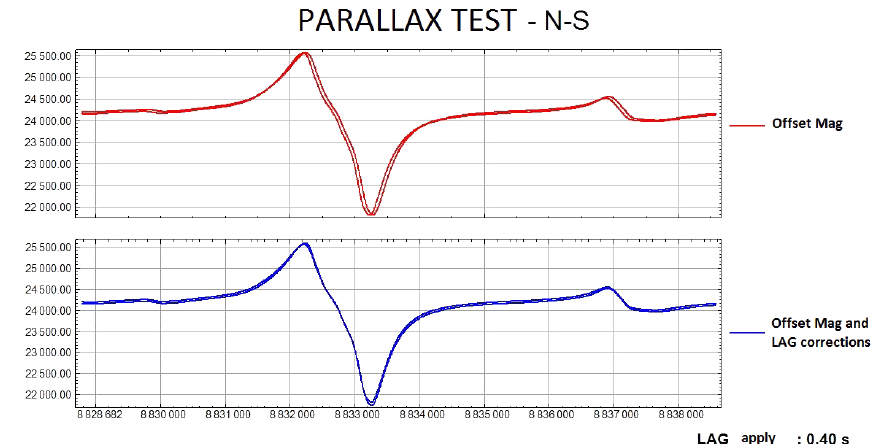
Figure 13. LAG test results model applied to magnetic measurements (source: S. Guimarães, author private collection, May